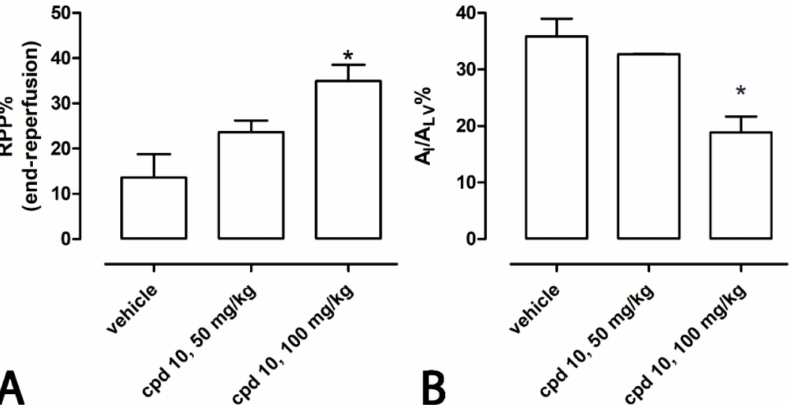
Figure 3. The histograms represent the functional and morphological changes induced by treatment of the animals with compound 10 or with vehicle before I/R episode. ( A ) Changes in RPP% at the end of reperfusion; ( B ) changes in the percentage of ischemic area vs. left ventricle area (A I /A LV %). The vertical bars symbolize the standard errors ( n = 6). Asterisks show a statistically significant difference from the value observed in the hearts of vehicle-treated animals (* p <